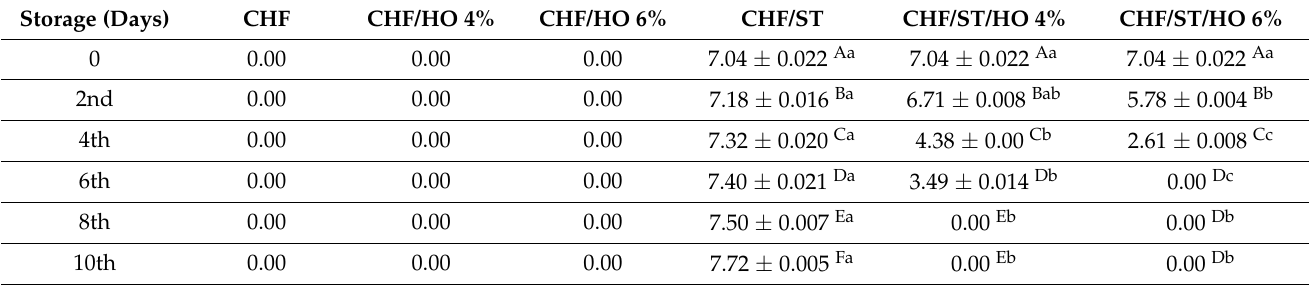
Table 3. Antibacterial effect of different concentration from lyophilized HO algal extract against S. aureus experimentally inoculated in chicken fillet stored at 4 ◦ C (mean ±